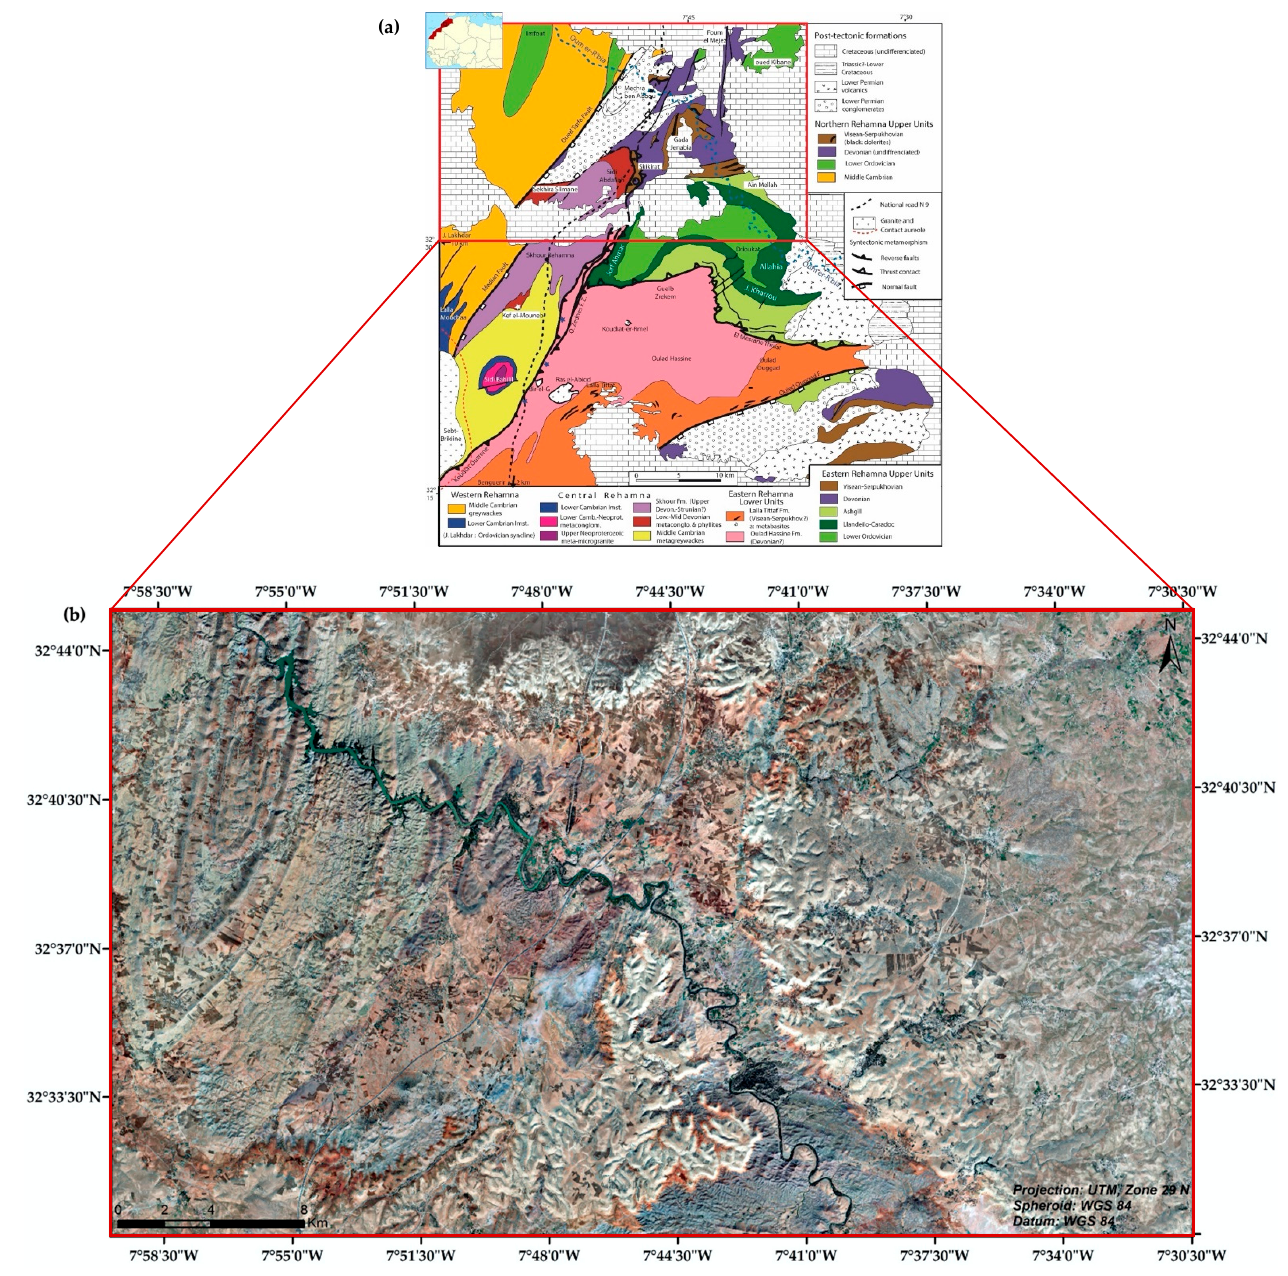
Figure 1. ( a ) Location of the Paleozoic massif of Rehamna (structural and metamorphic map of the Rehamna massif); ( b ) Google Earth imagery of the study area with a resolution of 2 m.